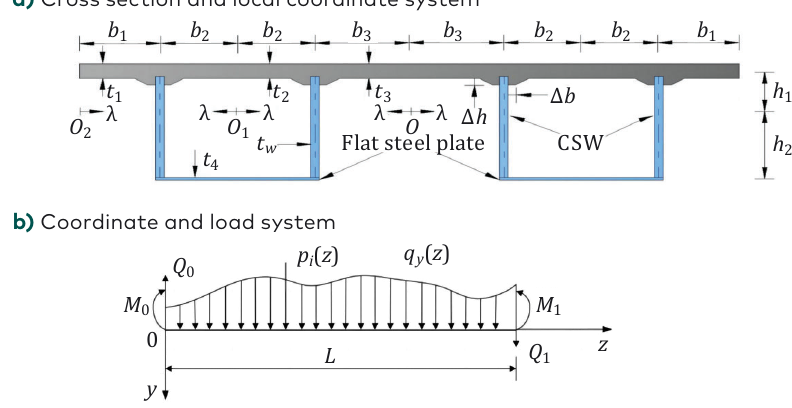
Figure 2. A CW-SBS box girder with corrugated steel